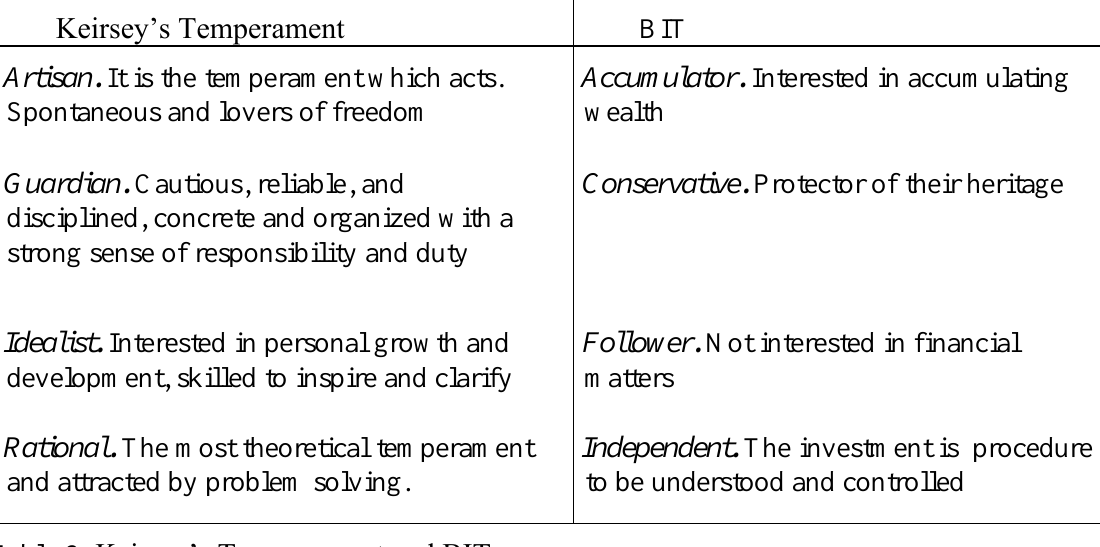
Table 2: Keirsey’s Temperament and